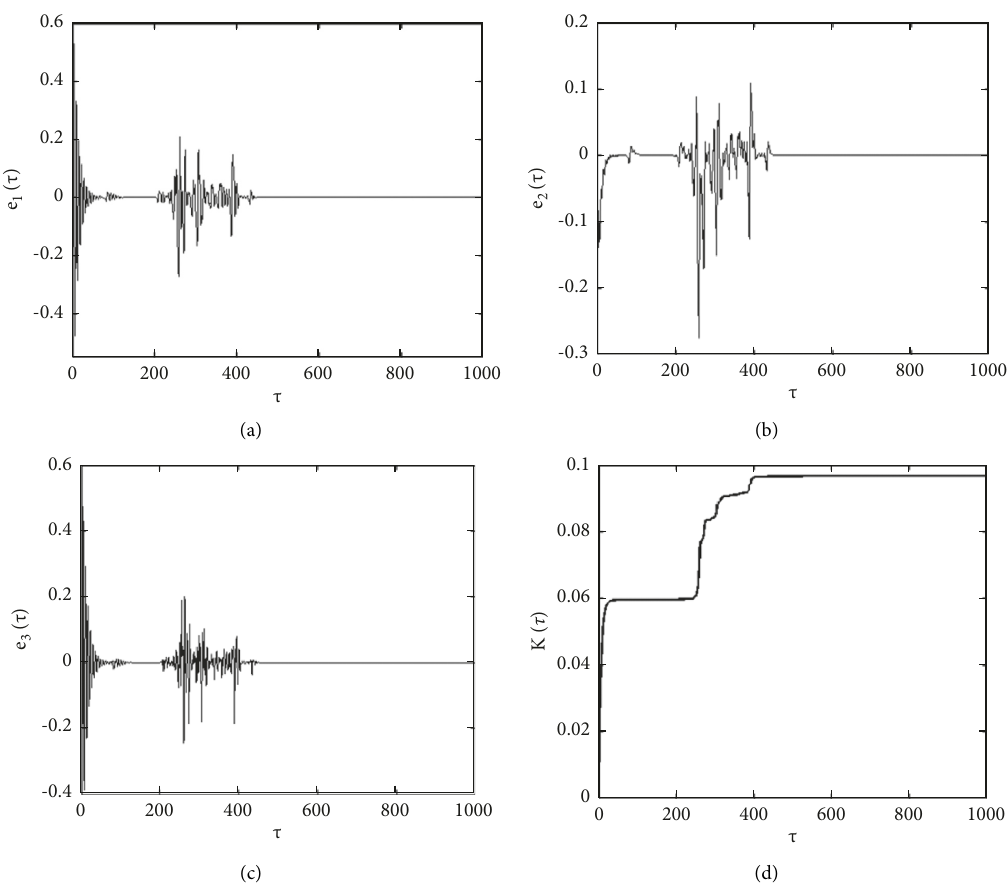
Figure 8: Global synchronization errors (a) to (c) and adaptive coupling strength (d) for c 0 , 0 . 1 , 0 . 2 , 0 , 0 . 15 , 0 . 25 , and 0 . 3 , 0 . 2 , 0 . 4 , respectively, for the outer 1, outer 2, and relay oscillators. ( ) ( ) ( )